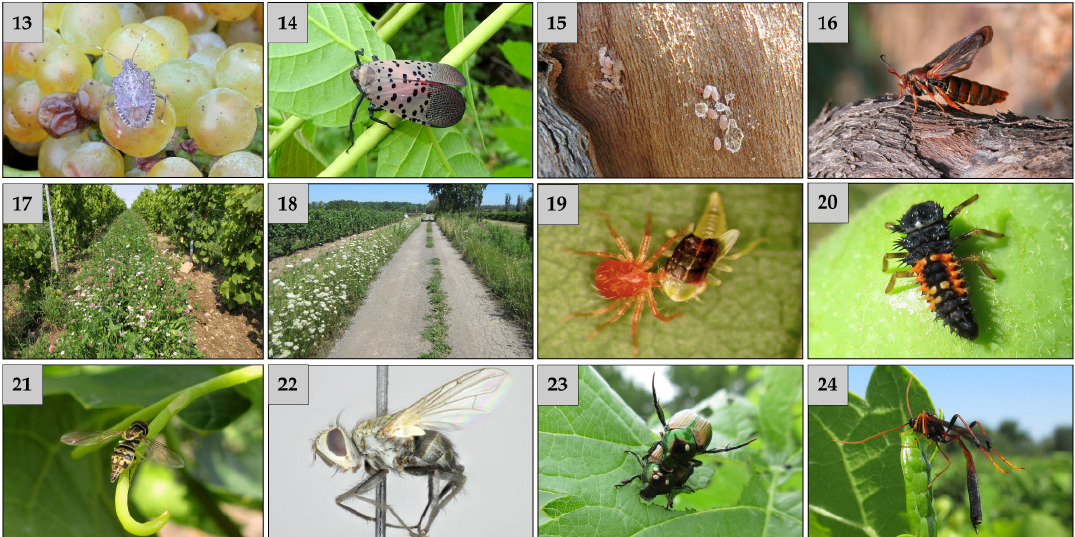
Figure 2: (13) Adult brown marmorated stink bug, Halyomorpha halys (Pentatomidae) (D. Pfeiffer); (14) Adult spotted lanternfly , Lycorma delicatula (Fulgoridae) (D. Pfeiffer); (15) Grape mealybug , Pseudococcus maritimus (Pseudococidae)(J. Lasnier); (16) Grape root borer, Vitacea polistiformis (Sesiidae) adult (C. Bergh); (17) Flower strips in middle row of a vineyard (J. Lasnier); 18) Flower strips at the perimeter of a vineyard (J. Lasnier); 19) Anystis baccarum (Anystidae) feeding on Erythroneura vitis (Cicadellidae) nymph (J. Saguez); 20) Multicoloured asian lady beetle, Harmonia axyrydis (Coccinellidae) fourth larval stage (J. Lasnier); 21) Toxomerus spp. (Syrphidae) fly (J. Lasnier); 22) Istocheta aldrichi (Tachinidae) adult (J. E. O’Hara); 23) Istocheta aldrichi (Tachinidae) eggs on adult japanese beetle, Popillia japonica (Scarabeidae) (J. Lasnier); 24) Therion fuscipennis (Ichneumonidae)(J. Lasnier).